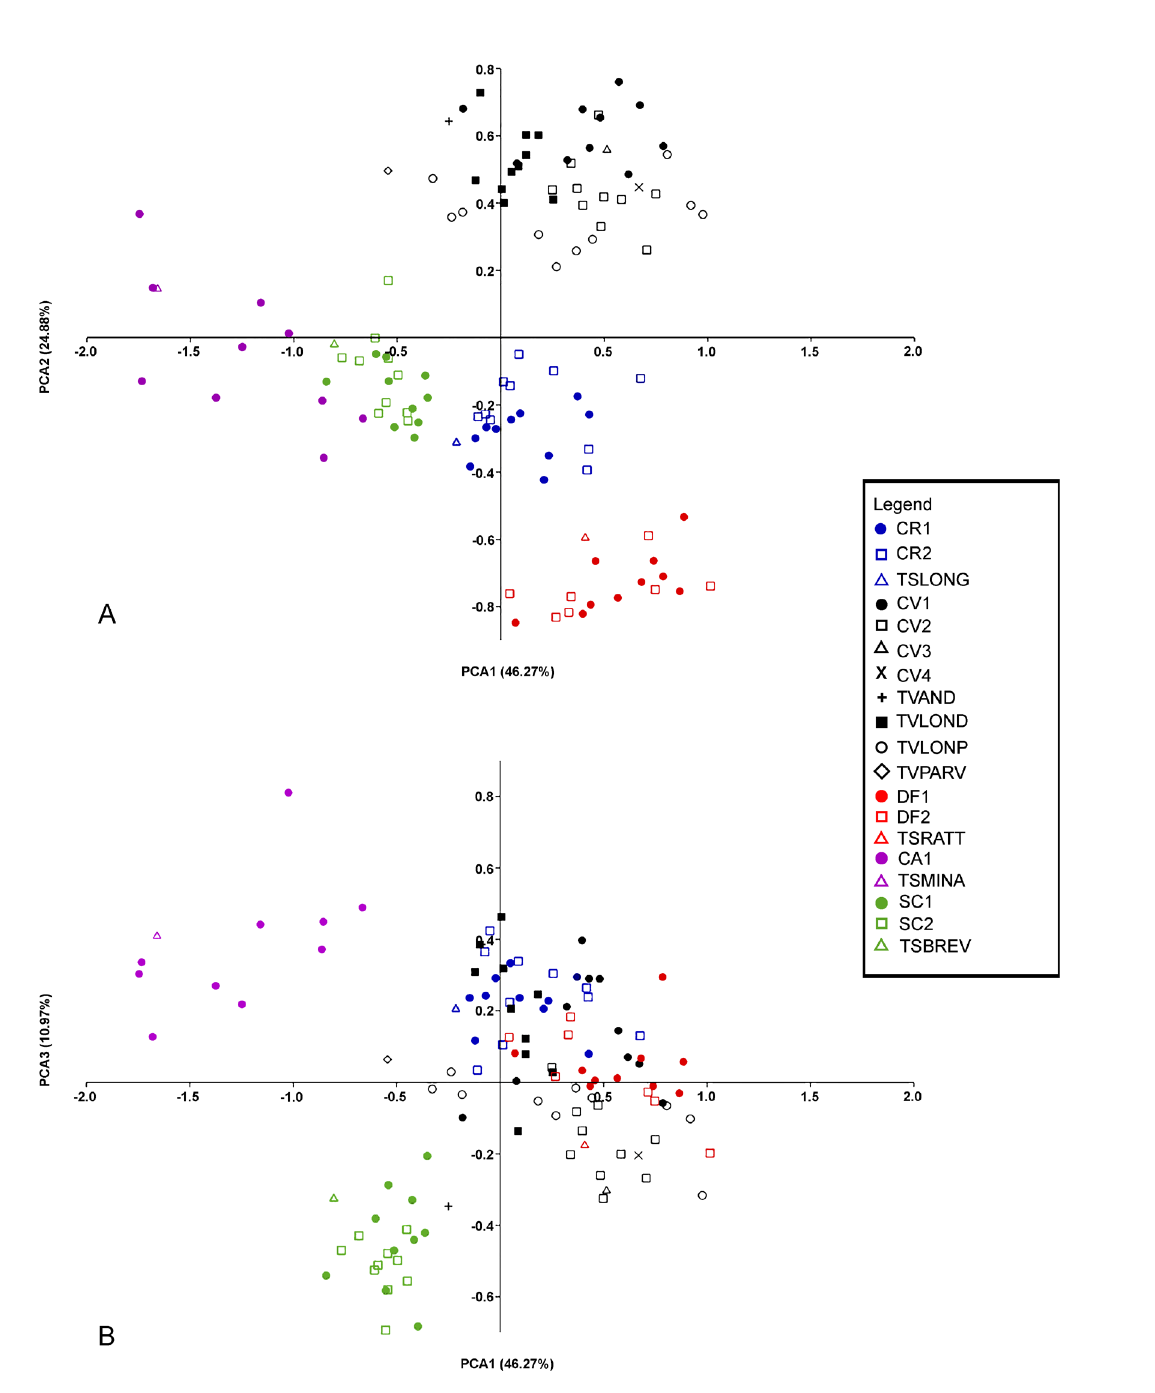
Fig. 2. Scatterplots derived from Principal Component Analysis of 11 natural populations and eight type specimens of the Stachytarpheta longispicata complex. A . Plot of principal component (PC) 1 vs PC2. B . Plot of PC1 vs PC3. For explanation of OTUs see Table